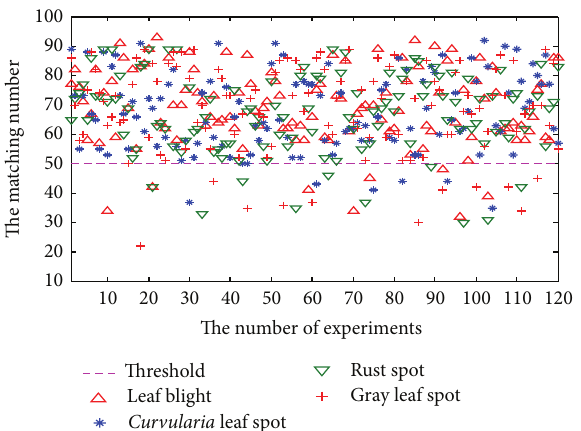
Figure 16: Recognition rates between the same diseases.